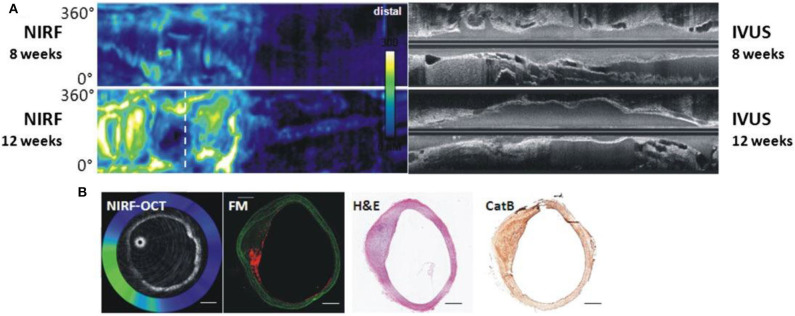
Dual modality NIRF-OCT along separate IVUS images, obtained at weeks 8 and 12 following balloon injury in rabbit aorta. ProSenseVM110 is the fluorophore used to acquire NIRF imaging. (A) Longitudinal rabbit aorta sections. To the left, co-registered OCT-NIRF images and to the right corresponding IVUS images. (B) Cross sections of rabbit aortas corresponding to white dotted line in (A). From left to right: cross-sectional co-registration of NIRF-OCT images (Green/white = high near-infrared fluorescence; blue/black = low near-infrared fluorescence), matched cross-sectional fluorescence microscopy (FM) (red = ProSense VM110; green = autofluorescence) and histopathological sections reveals increased ProSense VM110 NIRF signal within a moderate fibrofatty atheroma (H&E) associated with cathepsin B immunostain. Scale bars, 1 mm. Figure courtesy of Dr. Eric Osborn and Dr. Giovanni Ughi. Bourantas et al. (67), by permission of European Society of Cardiology. License Number: 4720391246688.